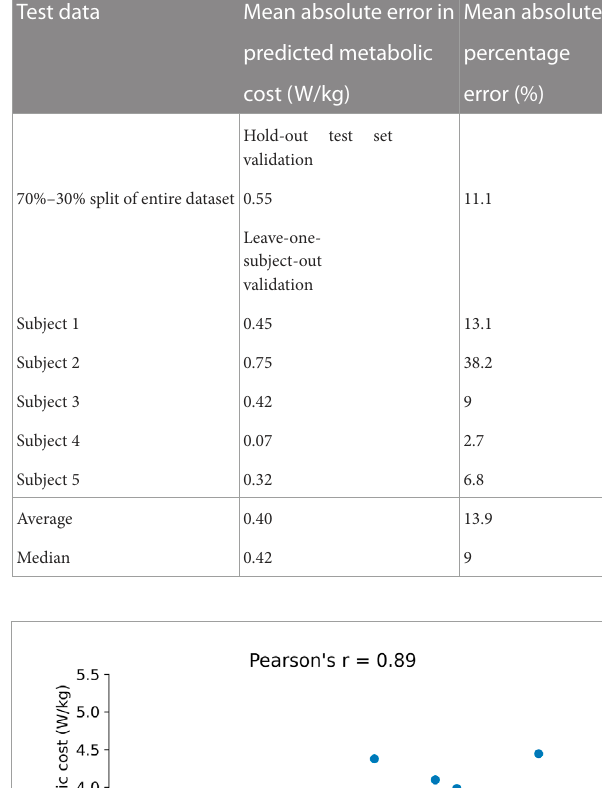
TABLE2 Metaboliccostpredictionperformanceoftherandomforest regressoronthehold-outtestdatasetandunseentestsubjects,usingthe LOSO(leave-one-subject-out)method.